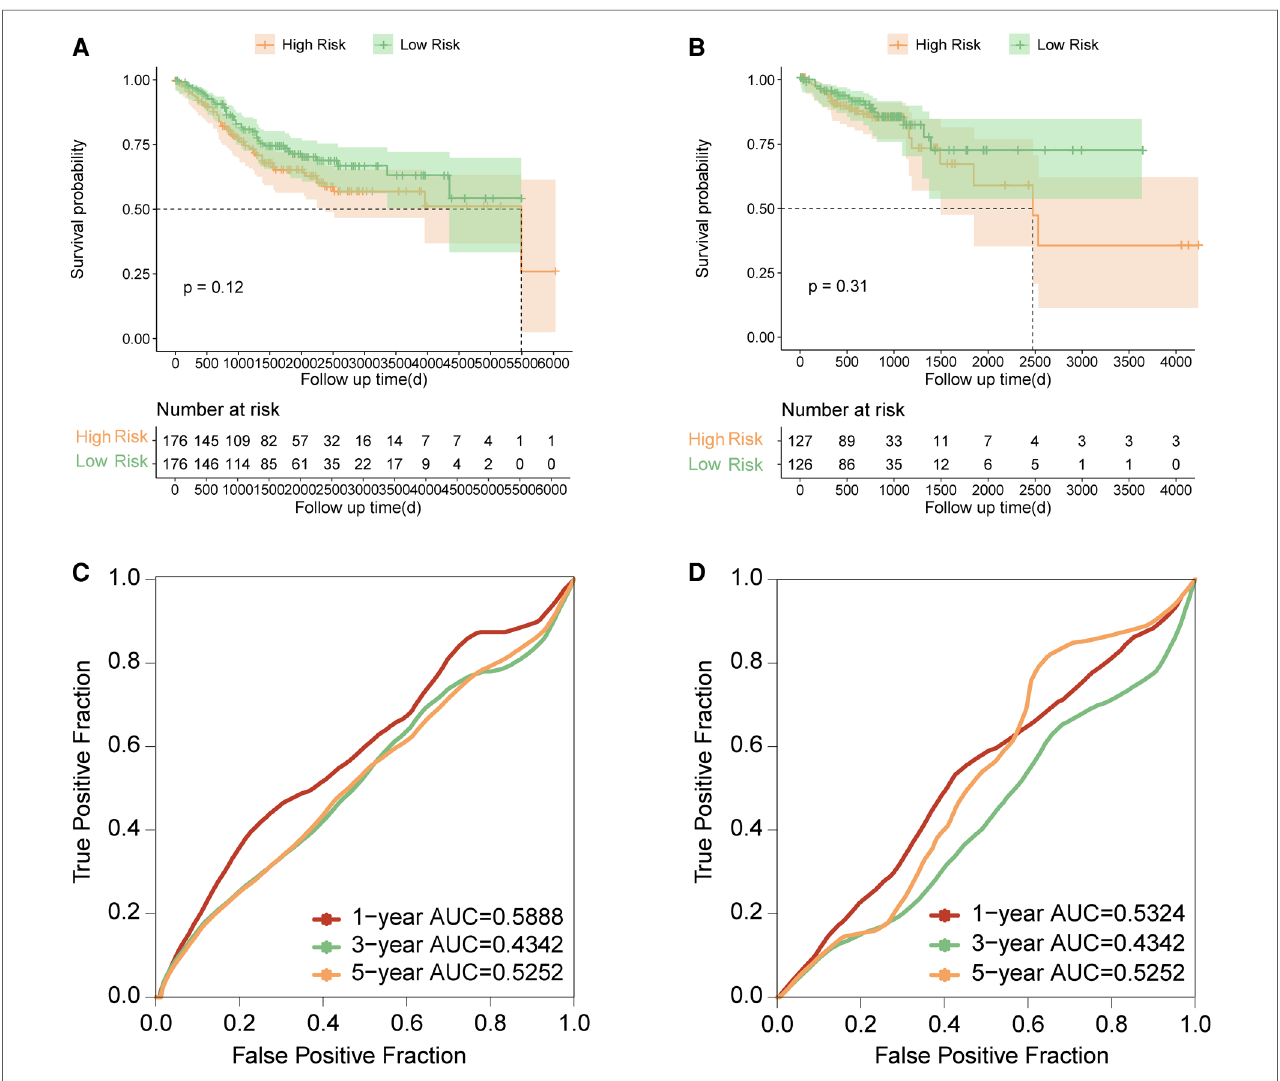
FIGURE 4 Evaluation and validation of the established signature in TP53 wild-type COAD. ( A ) Kaplan – Meier survival curve between high risk and low risk groups in TP53 wild-type samples of GSE39582. ( B ) Kaplan – Meier survival curve between high risk and low risk groups in TP53 wild-type samples of combined RNA-seq cohort. ( C ) Time-dependent ROC curve in TP53 wild-type samples of GSE39582. ( D ) Time-dependent ROC curve in TP53 wild-type samples of combined RNA-seq